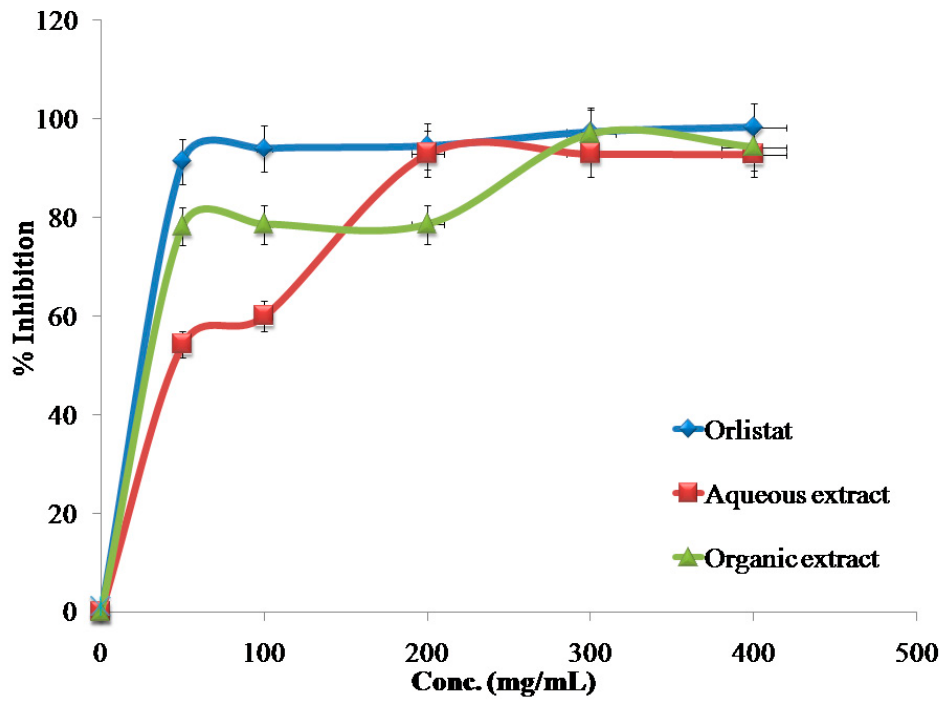
Figure 5. The inhibitory effects of the aqueous and organic extracts of O. dayi and Orlistat on the activity of porcine pancreatic lipase.